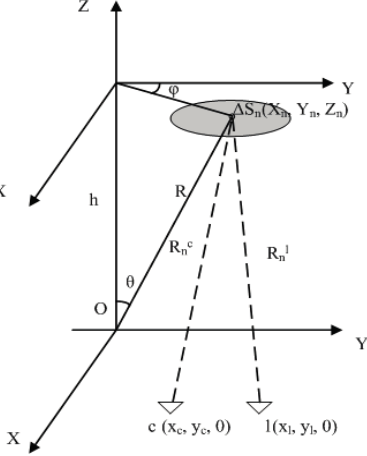
Figure 1. Interference measurement